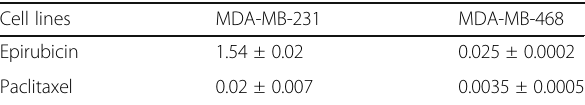
culture. Results are shown as mean ± SD. ( n = 3 independent